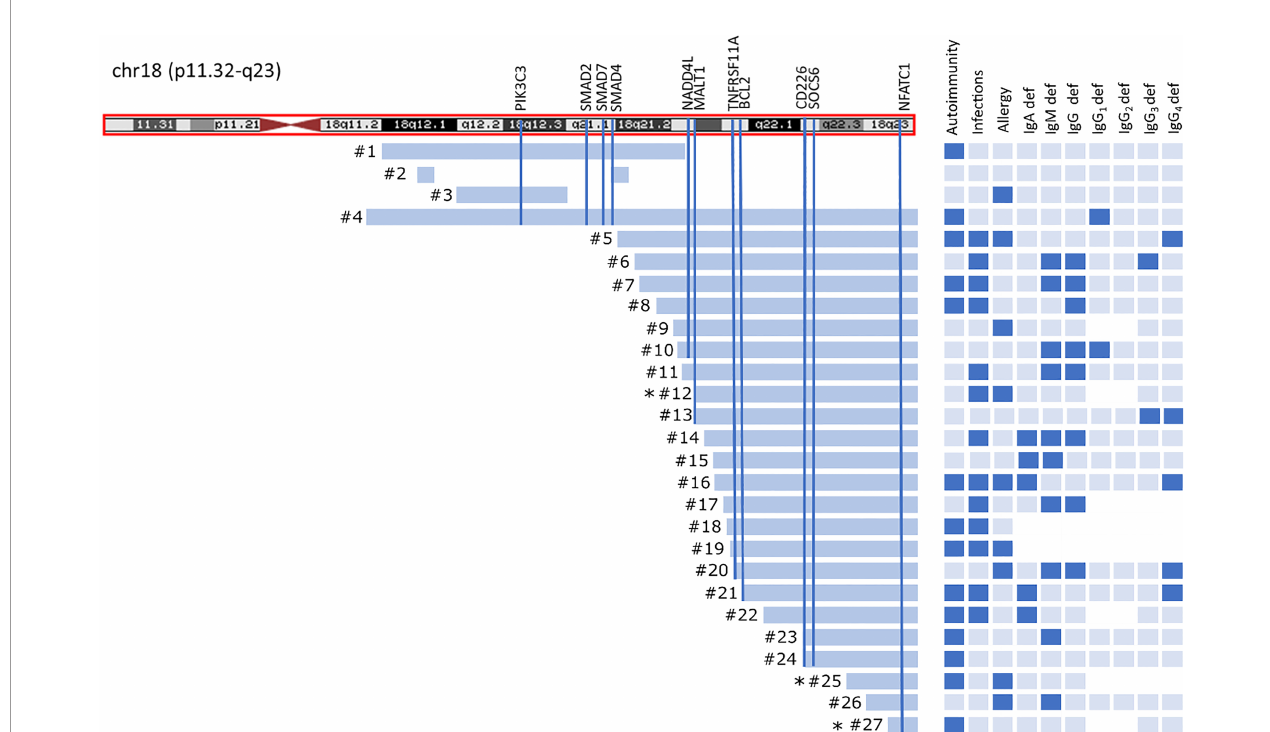
FIGURE 1 | Chromosome 18 ideogram showing the mapping of breakpoints in 18qdel cohort. Light blue bars depict deleted fragments of q arm each of the 27 study subjects in relation to clinical and laboratory fi ndings. Black asterisks indicates ring chromosome 18 with simultaneous deletion at